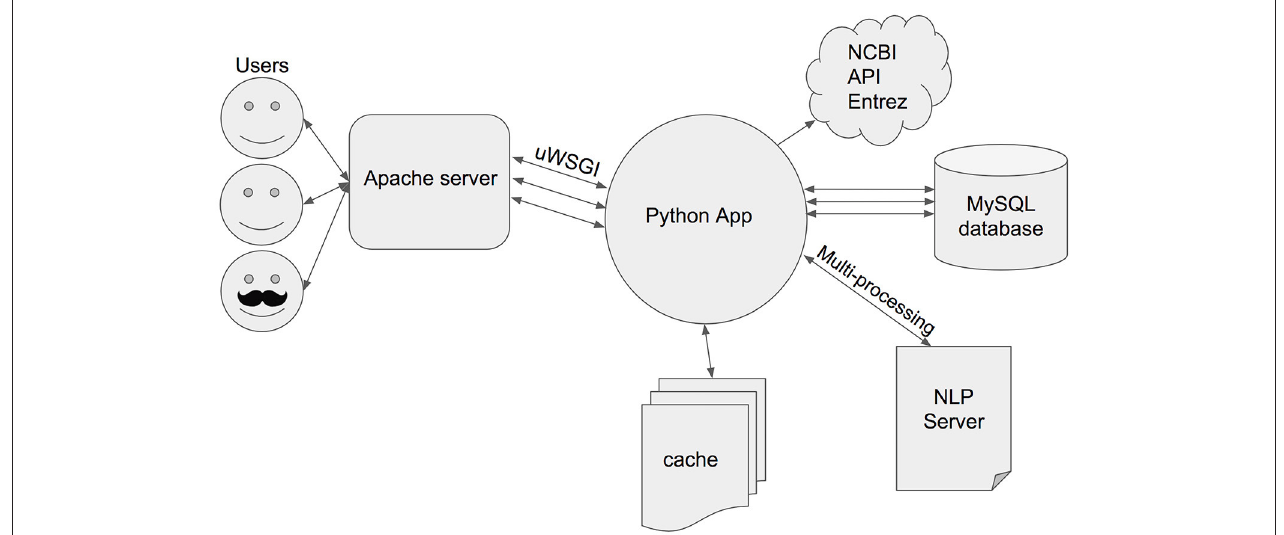
FIGURE 2 | SCKE’s system architecture. SCKE is a Python application run on an Apache web server. The Python app communicates with NCBI’s Entrez API in order to retrieve documents and relevant metadata. Documents annotated with the NLP server are cached, while the metadata is stored in our MySQL database. Multiprocessing is used when possible to speed up run time.